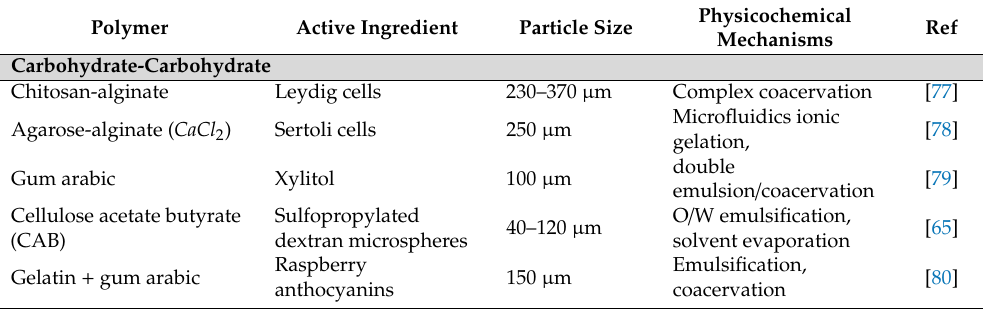
Table 6. Synergistic polymer